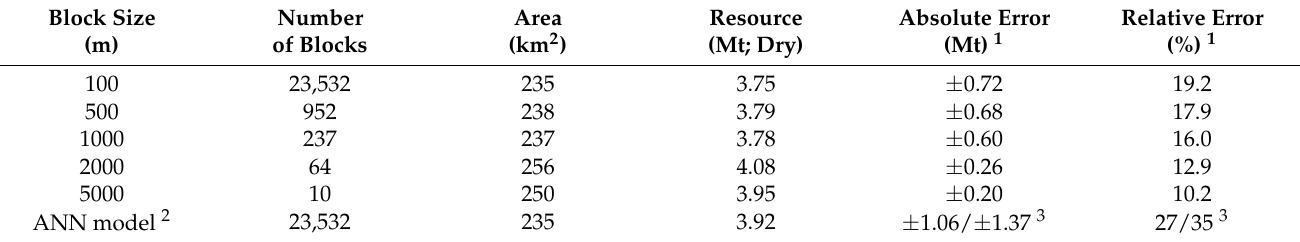
Table 7. Mn nodule resource estimations in PA1-West using different block sizes.